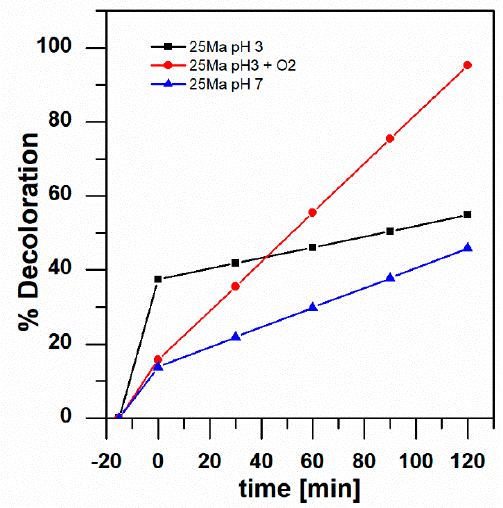
Figure 6. Percentage of degradation by photocatalysis of 1 mM aniline blue for the 25 Ma sample at pH 7 and pH 3 with and without the injection of air.